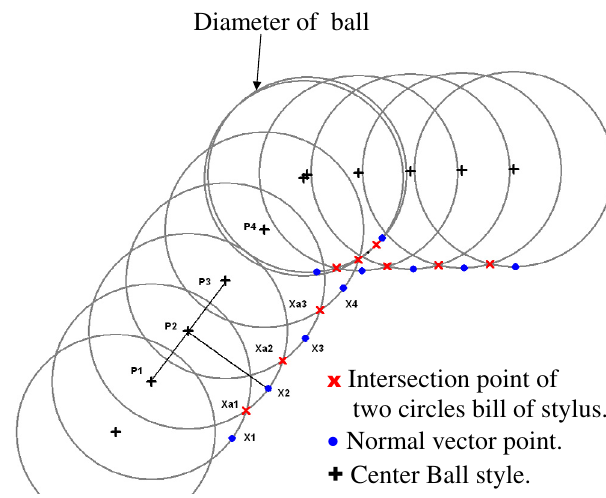
Fig. 3. (Color online) View